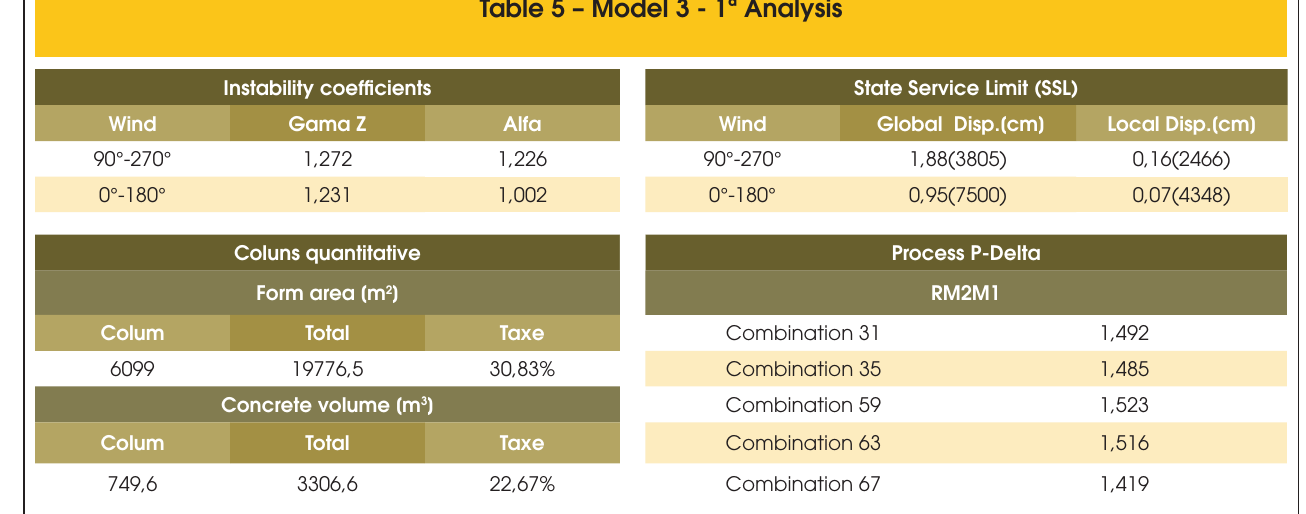
Table 5 – Model 3 - 1ª Analysis